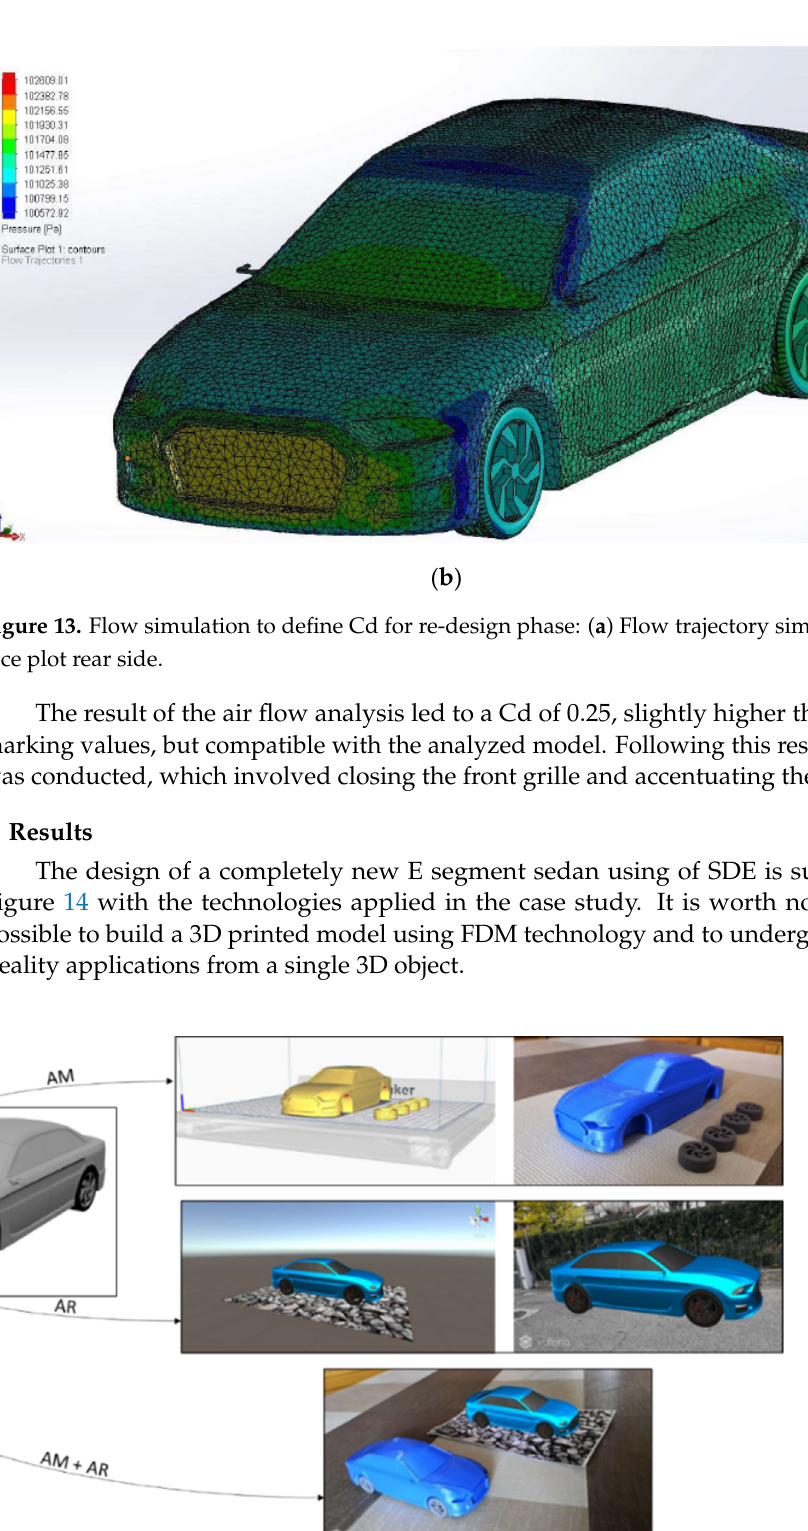
Figure 14. Results achieved from 3D car model in AR and AM.